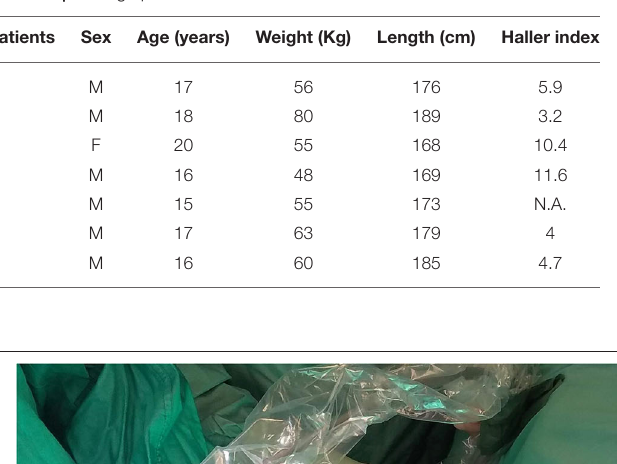
Frontiers in Pediatrics |